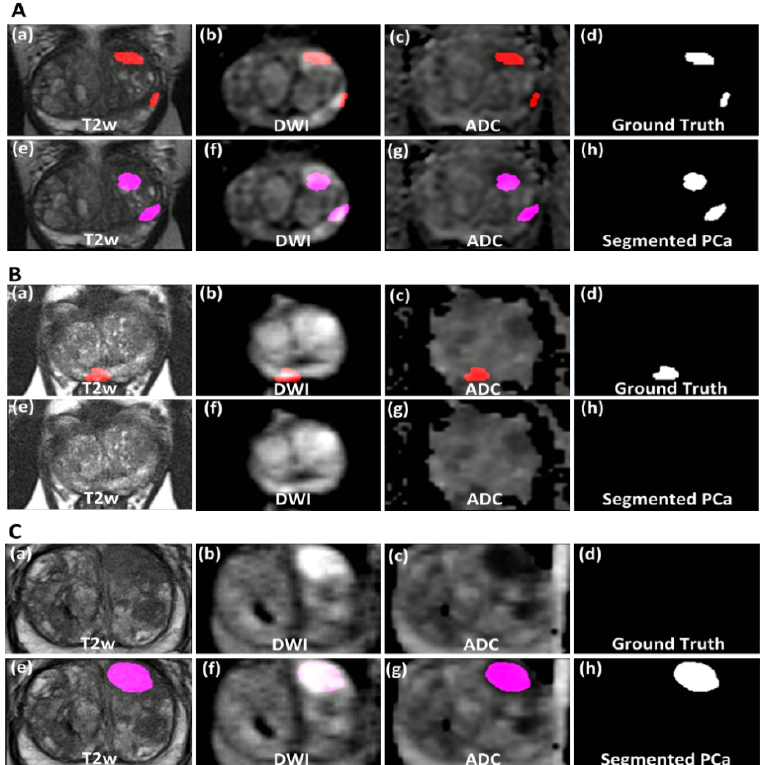
Figure 4. All images show the same axial slice as 2D view of mpMR images ( a , e T2w images; b , f DWI b800; c , g ADC map) of the prostate with the reference ground truth ( d ) and the segmented PCa lesion by the deep-learning model ( h ) ( A ) Example of a true positive case (PSA = 17.6; prostate volume = 46 cc; ISUP grade = 2 (up) and 3 (down)). The ground truth is shown in overlay (red) as delineated by the radiologist and proven by targeted biopsy as significant PCa. The segmented significant-PCa lesion by the deep-learning model is shown in overlay (pink). ( B ) Example of a false negative case (ISUP grade = 2). The ground truth is shown in overlay (red) as delineated by the radiologist and proven by targeted biopsy as significant PCa. The deep-learning model has not segmented any PCa lesion. ( C ) Example of a false positive case (ISUP grade = 1). The images show no delineation due to the absence of significant PCa, the region delineated by the radiologist (not shown) proved by targeted biopsy as insignificant PCa. The lesion segmented incorrectly by the deep-learning model is shown in overlay (pink).